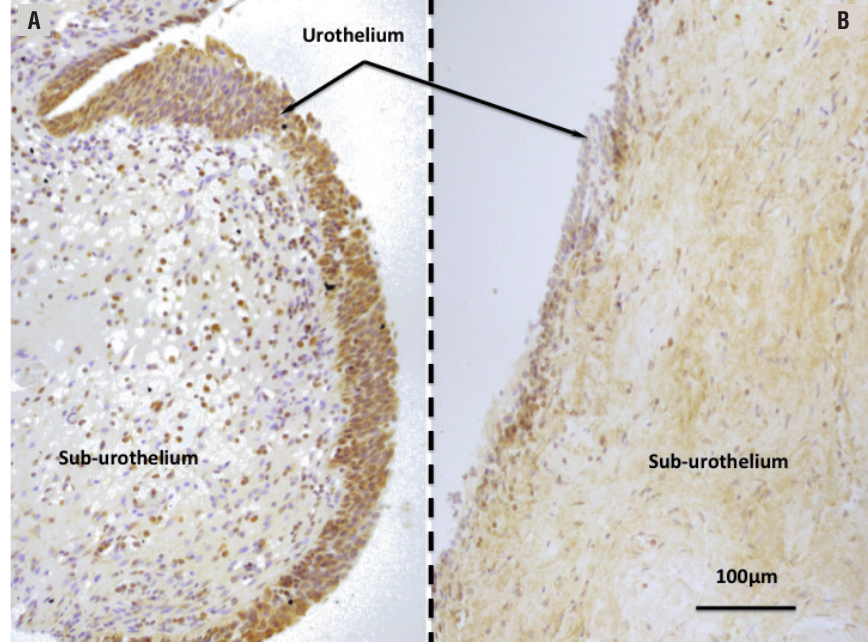
figure 1 - Microscopic features of sphingosine Kinase 1